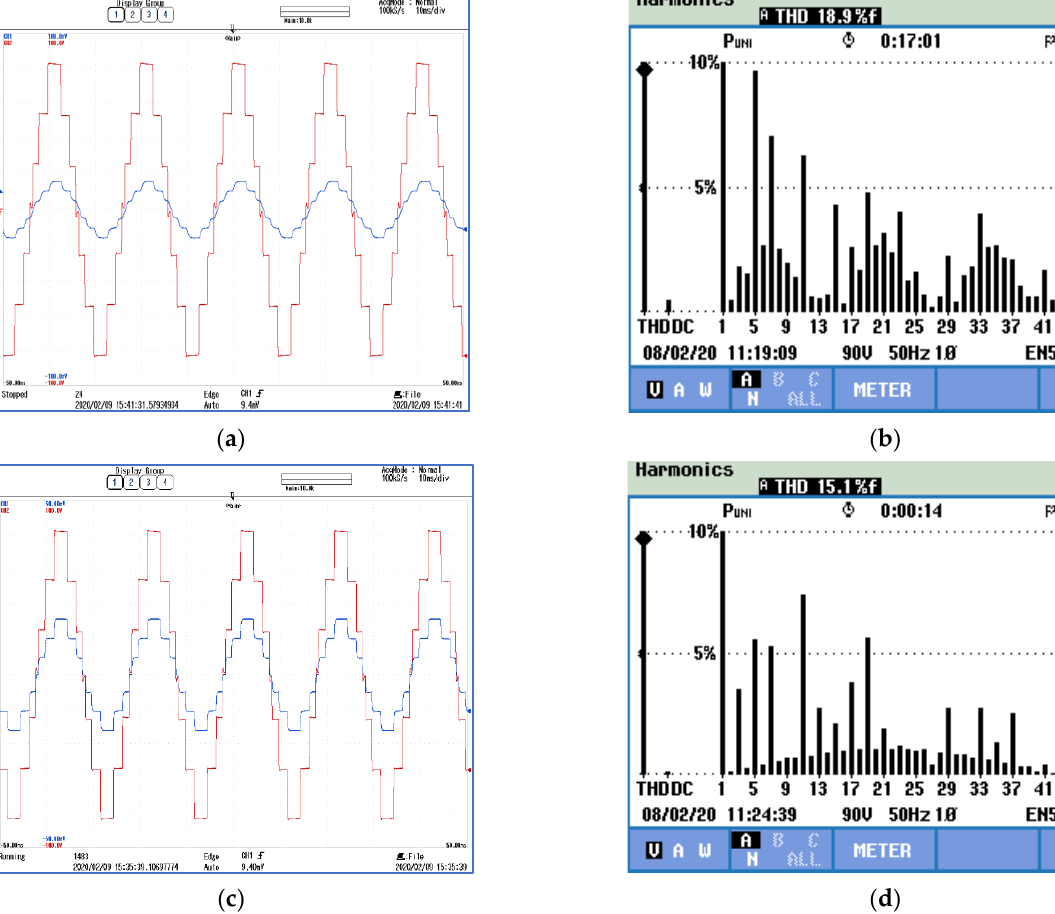
Figure 17. Hardware result of the Quasi-linear MLI for 9th order harmonic elimination using: ( a ) the conventional technique; ( b ) THD analysis of the conventional technique; ( c ) the proposed technique; and ( d ) THD analysis of the proposed technique.